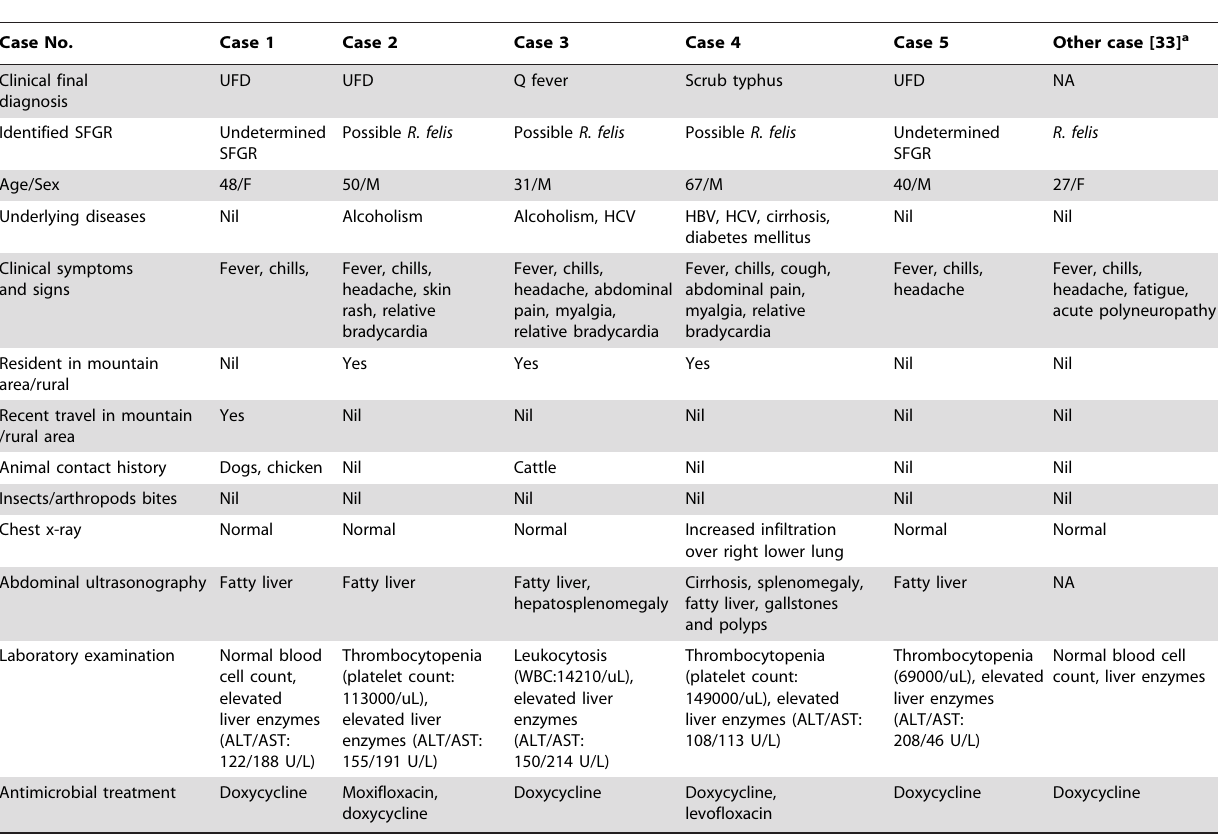
Table 3. Clinical characteristics of cases of acute infection of spotted fever group rickettsioses (SFGR) in Taiwan.